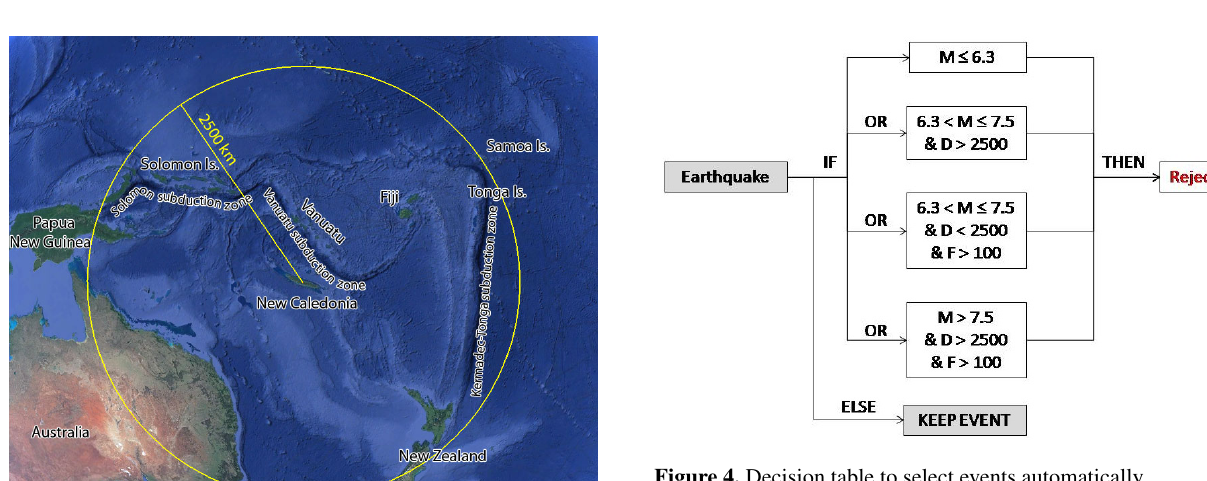
Figure 4. Decision table to select events